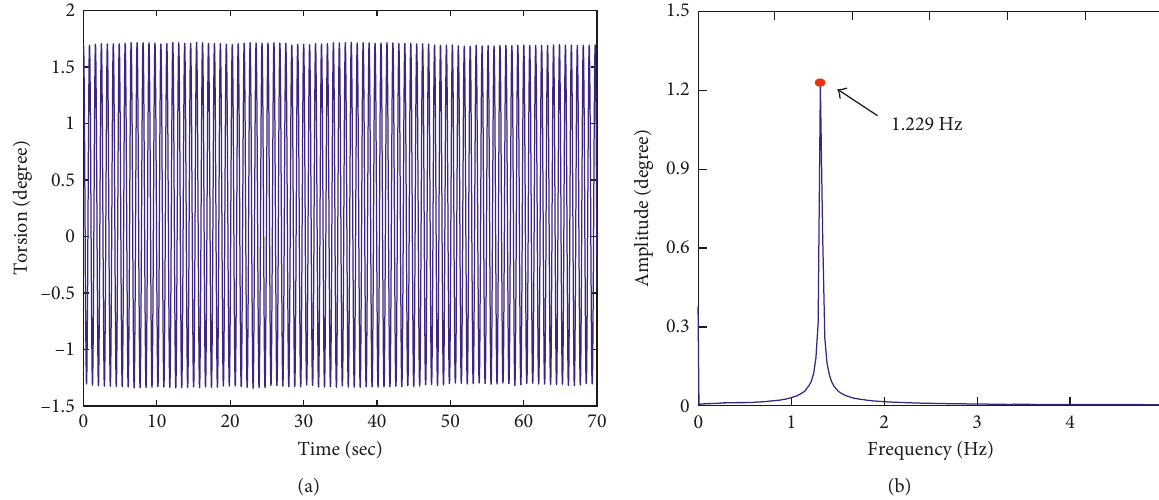
Figure 4: Signal transformation using FFT at 5.215m/s wind velocity. (a) Time history signal. (b) Frequency history signal.